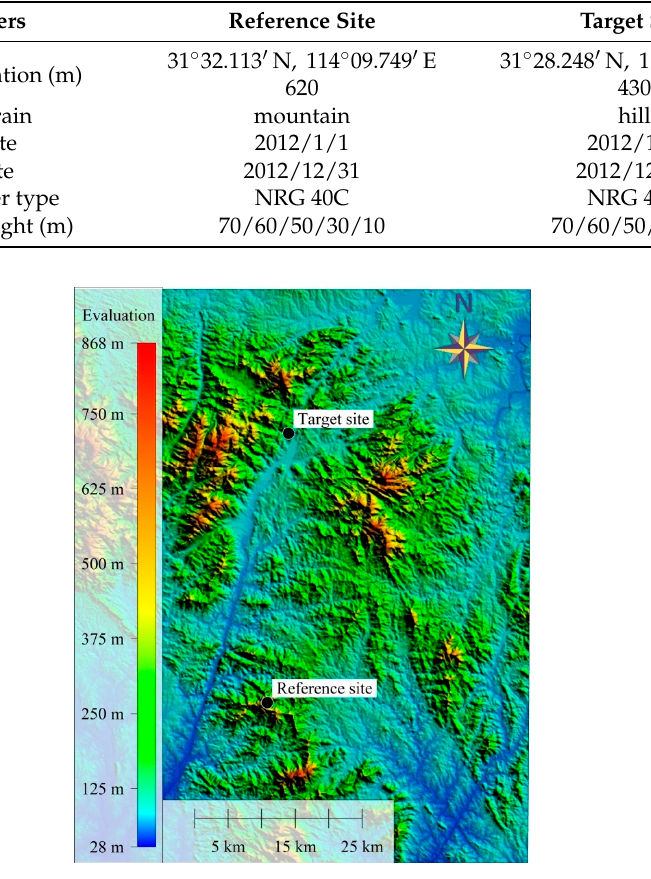
Figure 12. Evaluation map of region of interest. Solid dot show the target and reference site.